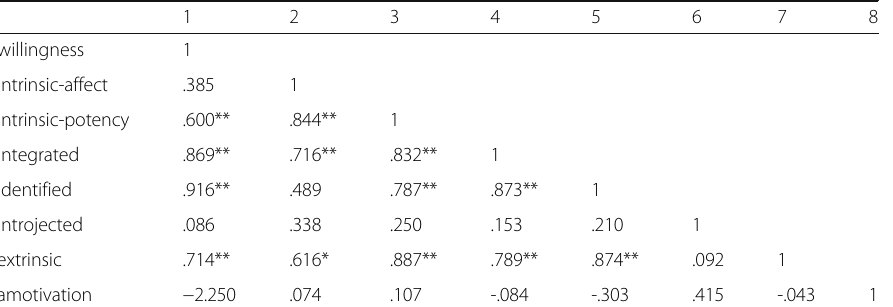
Table 8 Spearman